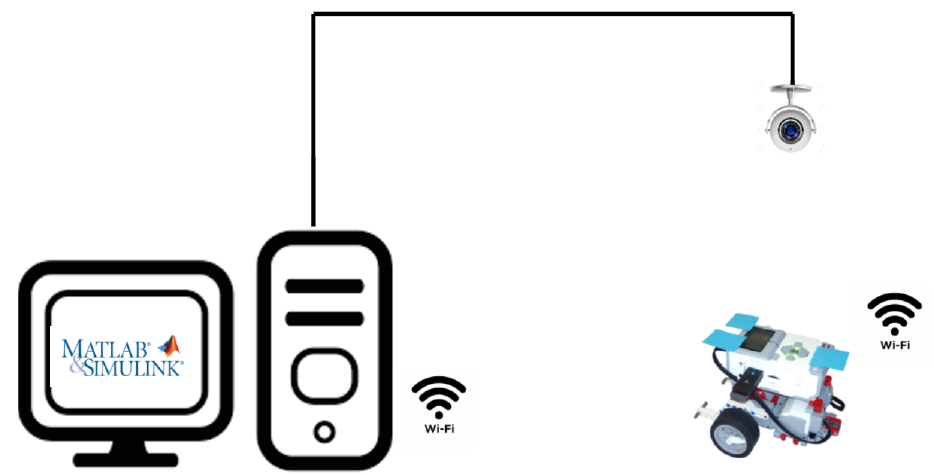
Figure 1. Experimental setup to test the